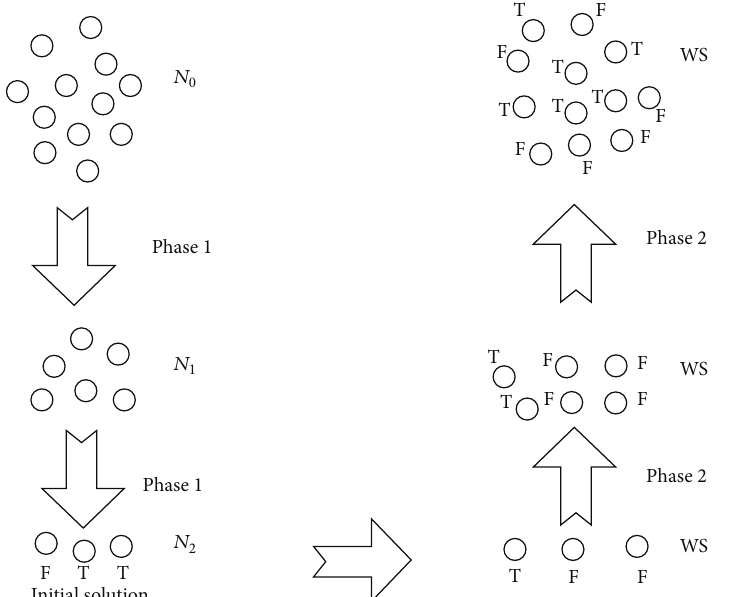
Figure 1: Example illustrating the different phases of the algorithm.